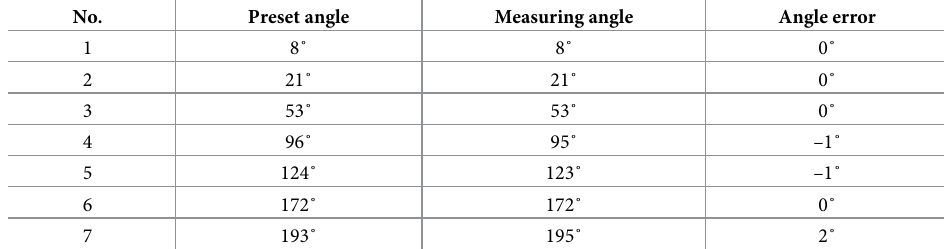
Table 4. Wind angle measurement